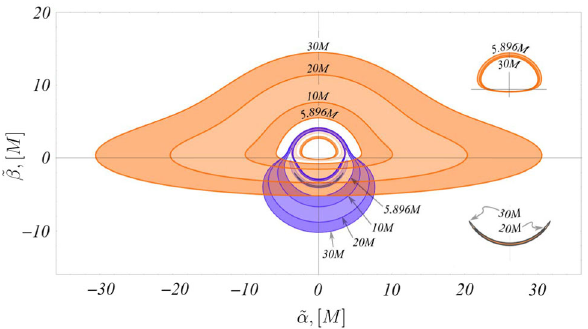
Fig. 4 Optical appearance of the strongly naked Janis–Newman– Winicour singularity with a thin accretion disk for γ = 0 . 48. The observer is located at r = 5000 M and the inclination angle i = 80 ◦ . The direct image of the accretion disk is depicted in orange, the sec- ondary image with k = 1 is in blue, while the higher order images are presented in black contour. The two marginally stable orbits, which delimit the inner and the outer disk, are located at r − = 4 . 271 M and r + = 5 . 896 M . In the side images we present a zoom-out of the second direct image of the outer disk (upper right), which forms a ring in the central region, and its image of order k = 2 (down right). The image of the inner disk is given in very light orange and very light blue in the main